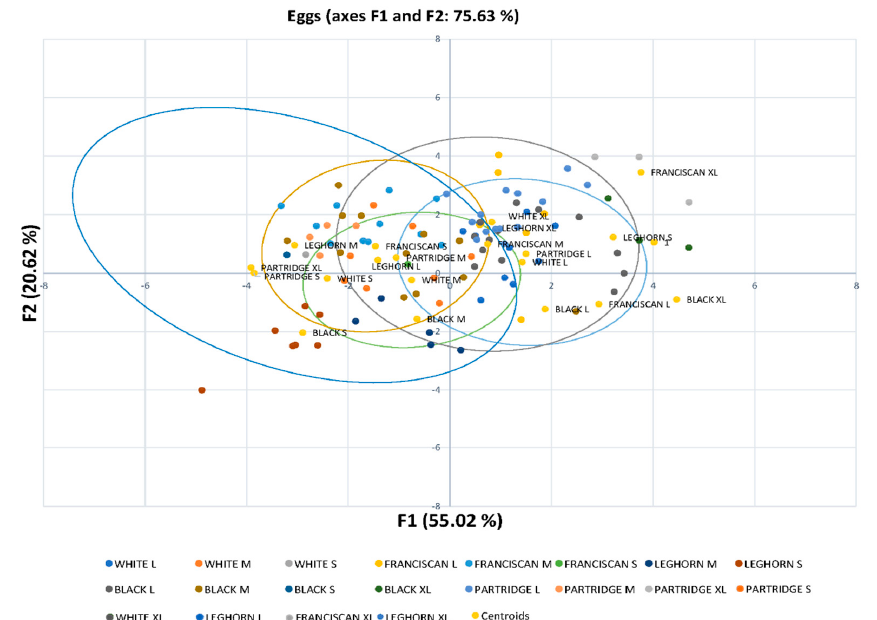
Figure 1. Territorial map depicting the eggs considered in the canonical discriminant analysis sorted across commercial quality categories (S, M, L, and XL) and laying hens genotypes (Leghorn and White, Black Franciscan, and Partridge Utrerana varieties). Centroids or canonical group means are the means for each group’s canonical observation scores. The larger the difference between centroids, the better the predictive power of the canonical discriminant function in classifying observations.